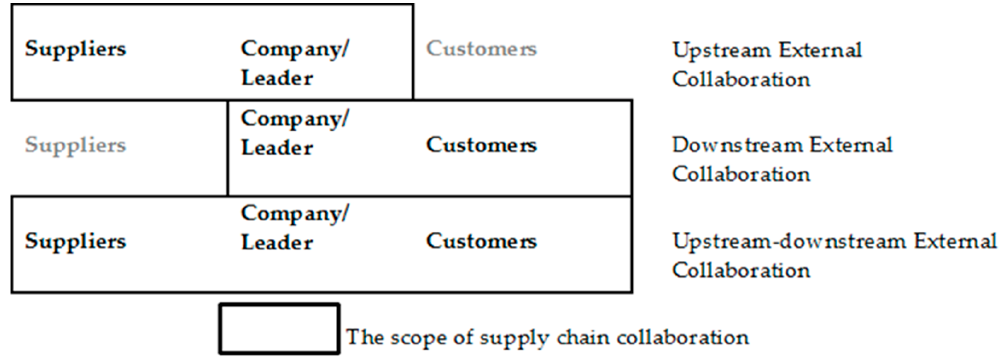
Figure 3. Forms of external vertical collaboration as part of the realisation of selected processes, projects, or resource allocation.